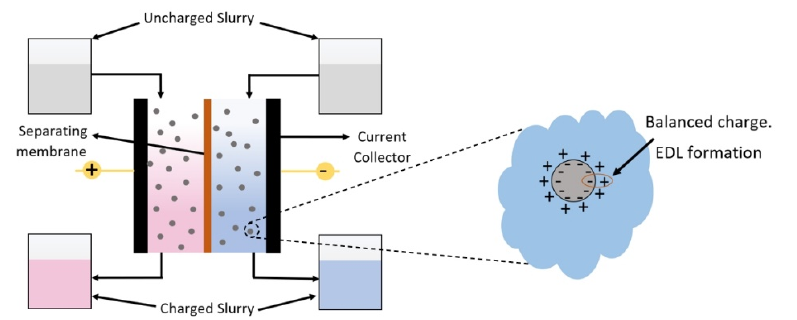
Figure 1. Schematic architecture of an EFC for charging slurry by EDL formation.